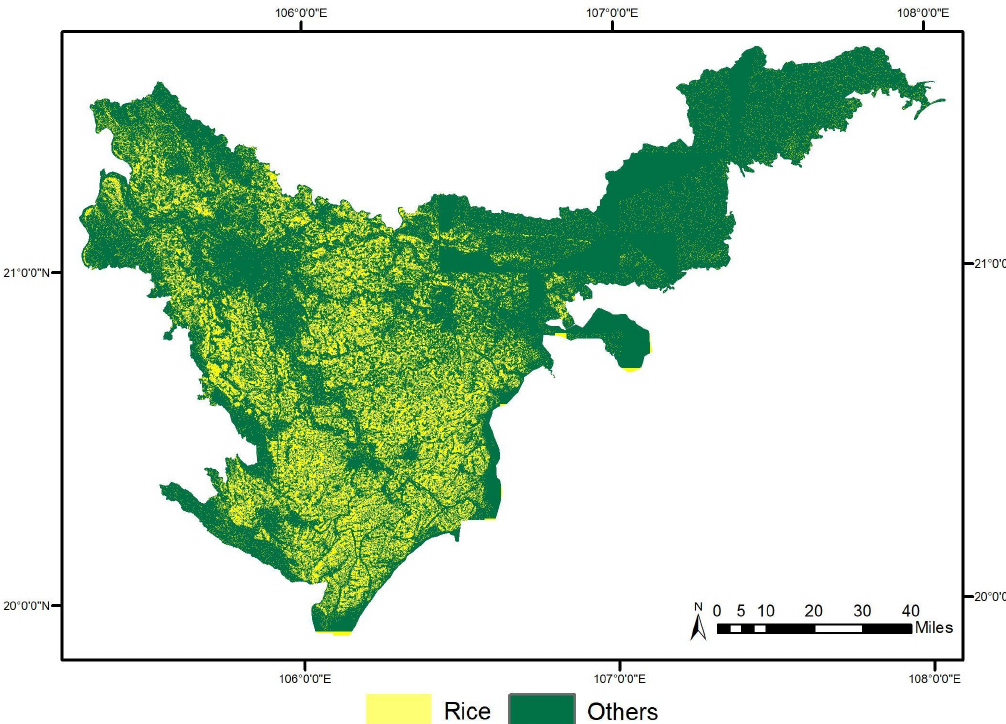
Figure 6. Correlation coefficient of estimated rice area to GSO statistics at province level in the RRD.